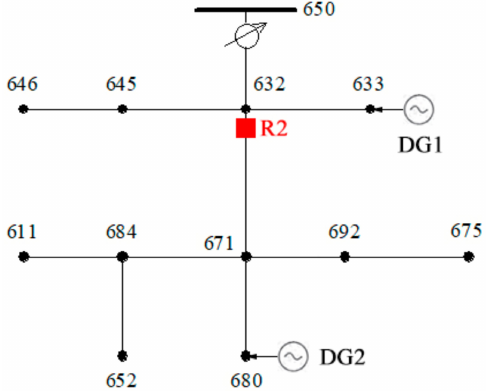
Figure 5. Structure of IEEE 13-node distribution system.